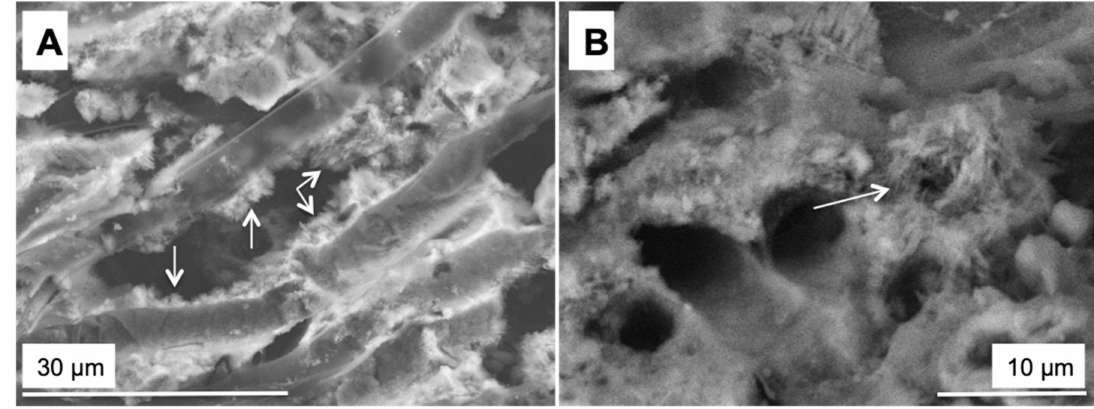
Figure 9. SEM images of elongated crystallite dendrites (white arrows) forming around ( A ) a longitudinal and ( B ) a transversal cut of Phormidiaceae filament